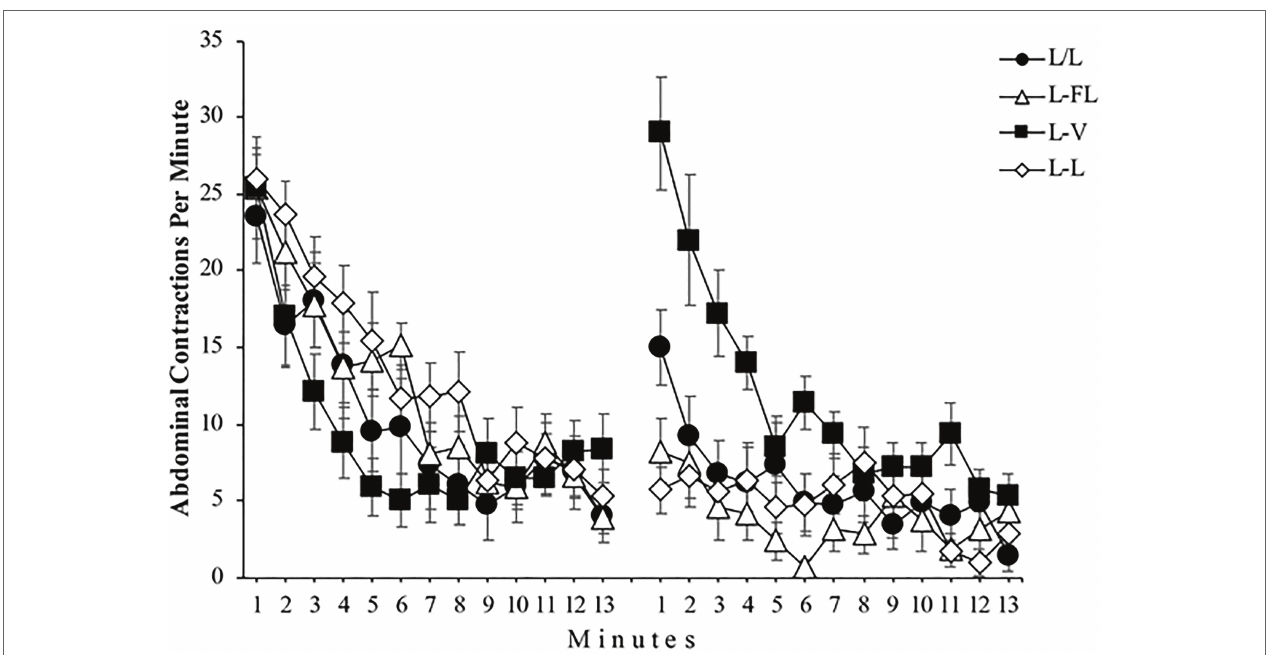
FIGURE 2 | Mean abdominal contractions during the 13 minutes of Phase 1 (left panel) and the 13 minutes of Phase 2 (right panel) of Experiment 1. Error bars denote standard errors of the